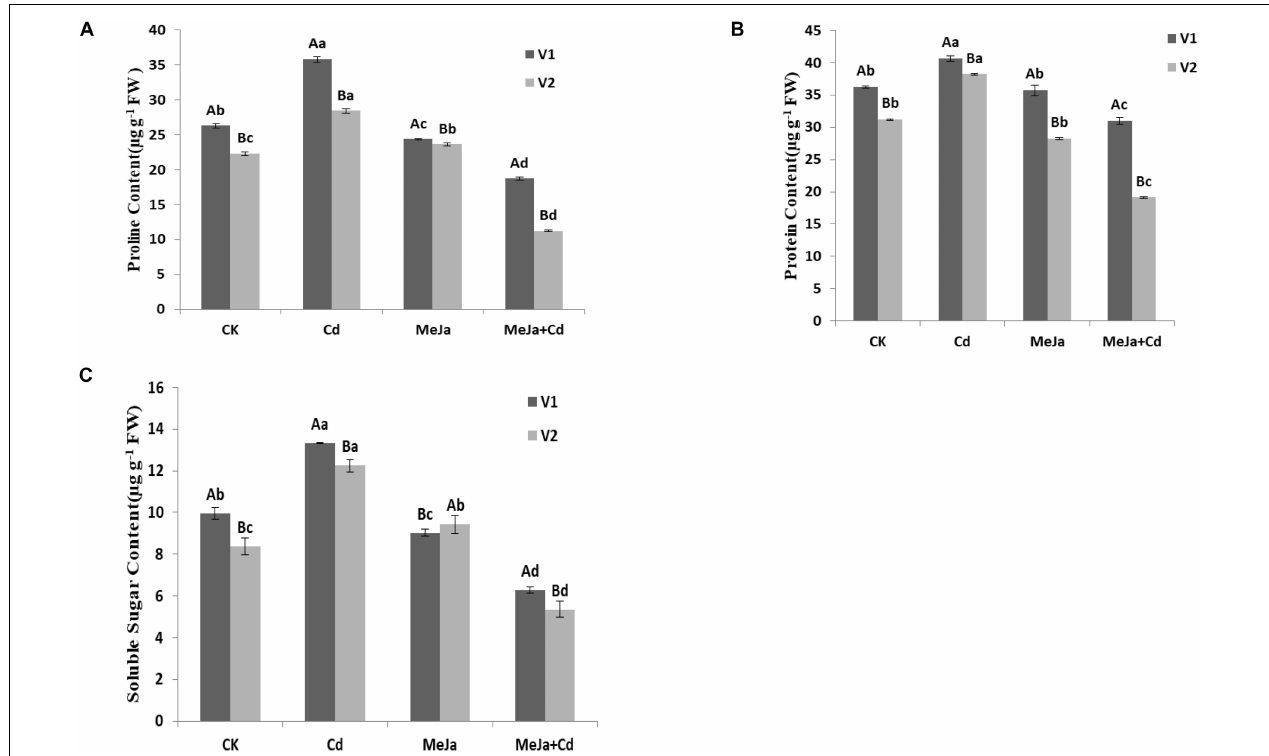
FIGURE 2 | The effects of MeJa on (A) proline, (B) protein, and (C) soluble sugars in two rice cultivars under Cd stress. The values are representative of three replicated means per treatment ± SE. Different letters indicate significant differences between cultivars and treatments at p < 0.05, LSD (V1 = Xiangyaxiangzhan and V2 = Meixiangzhan-2). TABLE 7 | The effects of exogenous MeJa application on Cd contents in different plant parts ( µ g/g dry weight) in two fragrant rice cultivars under Cd stress. Cultivar